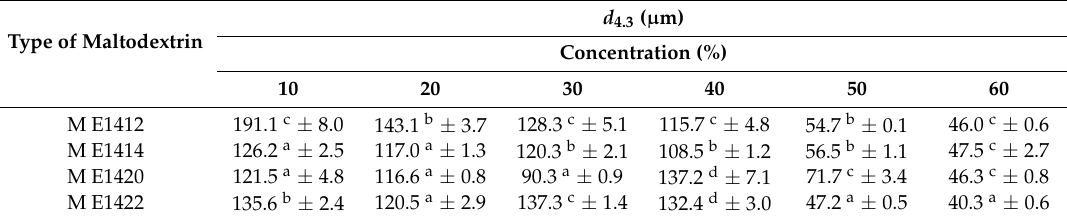
Table 3. Average diameter of oil droplets in freshly prepared emulsions stabilized by DE 16 maltodextrins